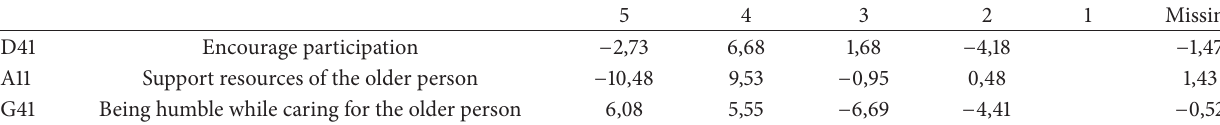
Table 14: Effects on distribution function when F41 fixed to “4” =